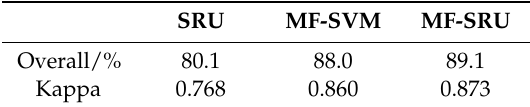
Table 3. Comparison of the overall accuracy and kappa coefficients.